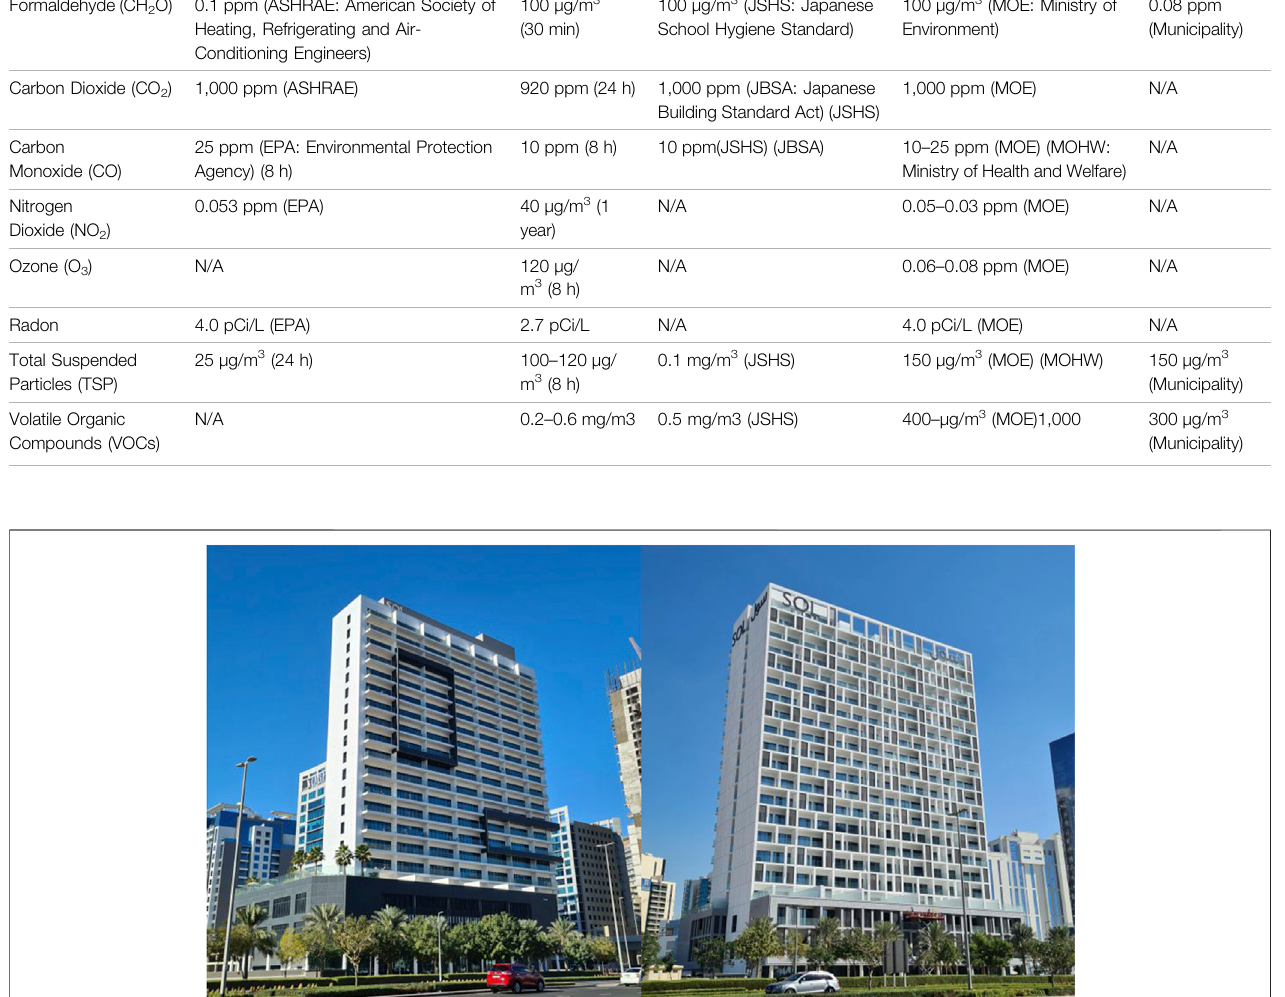
TABLE 3 | Global standards for indoor air quality (source: Jung, 2021). Hazardous substances